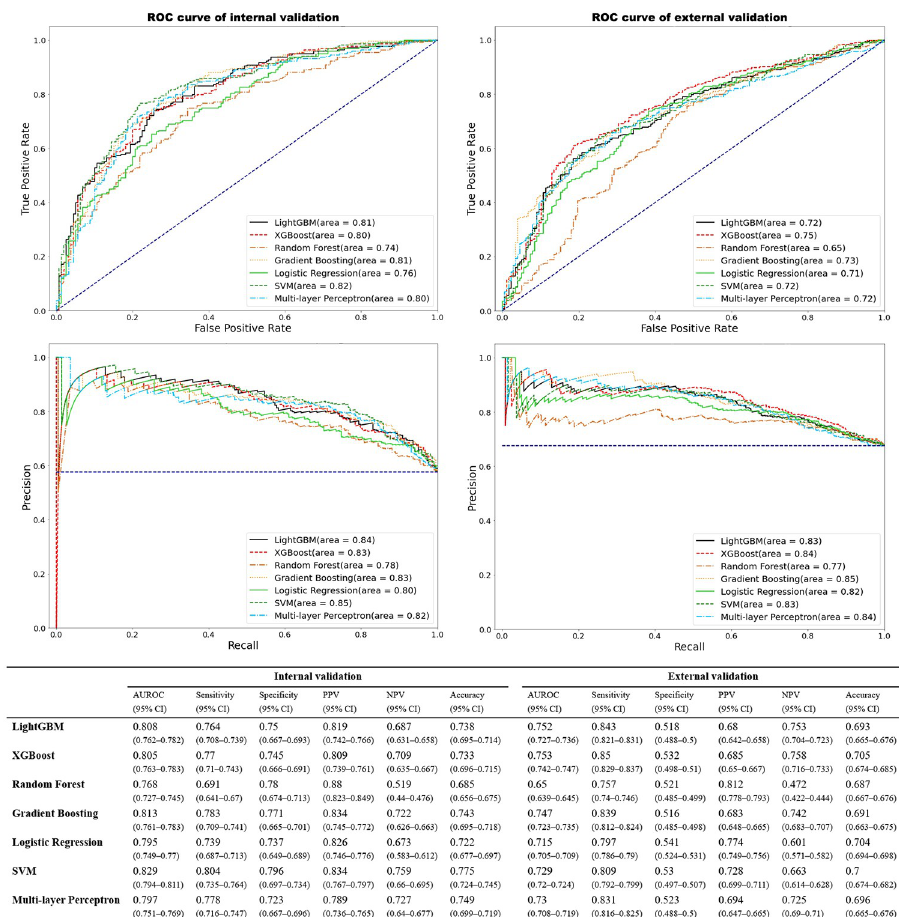
Fig 3. The precision using the fittest model with the importance variables determined by machine